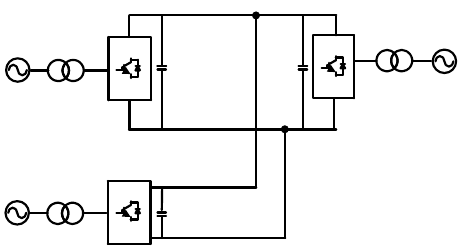
Figure 2. Configuration of the voltage ‐ source converter based multi ‐ terminal HVDC (VSC ‐ MTDC).